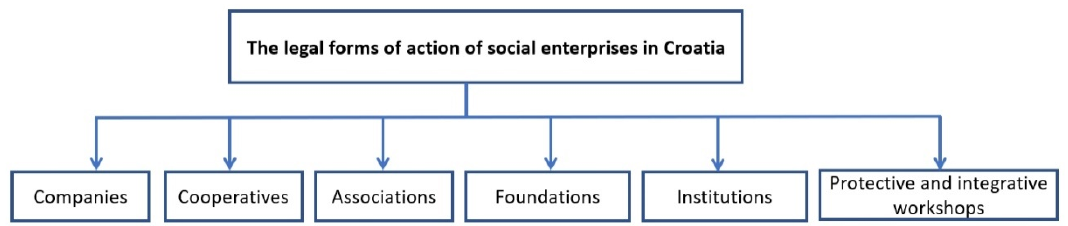
Figure 6. The legal forms of action of social enterprises in Croatia. Source: Authors.